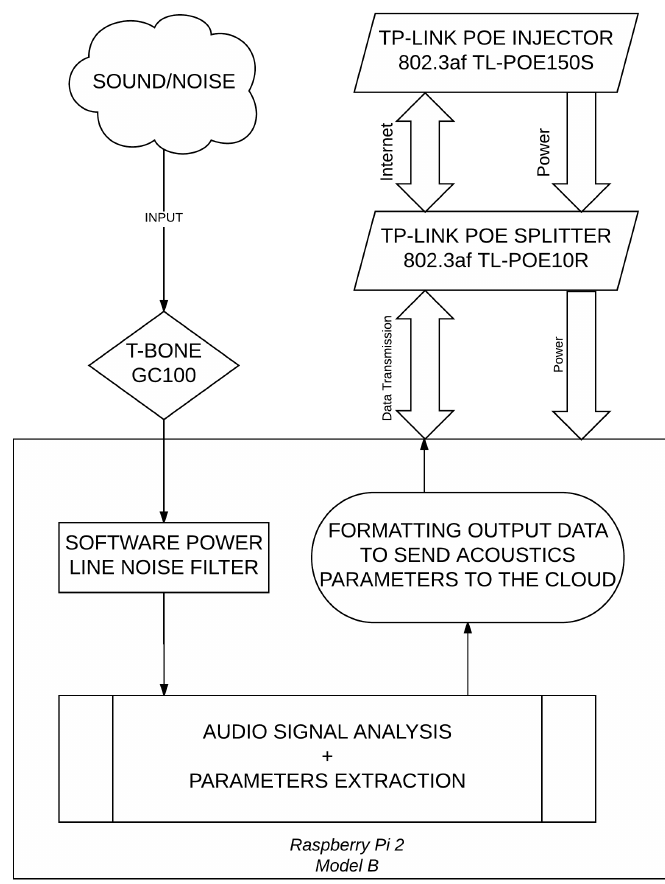
Figure 2. Block diagram of the complete system. The inputs of the system are the sound acquisition that goes through the T-Bone GC100 and the power and the Internet connectivity that are connected to the device through the TL-POE 150S Injector. In the Raspberry Pi 2 Model B, a digital filtering stage is in charge of removing any power line noises. The signal analysis and the parameters’ extraction are performed and their results are processed to send them to the cloud service.